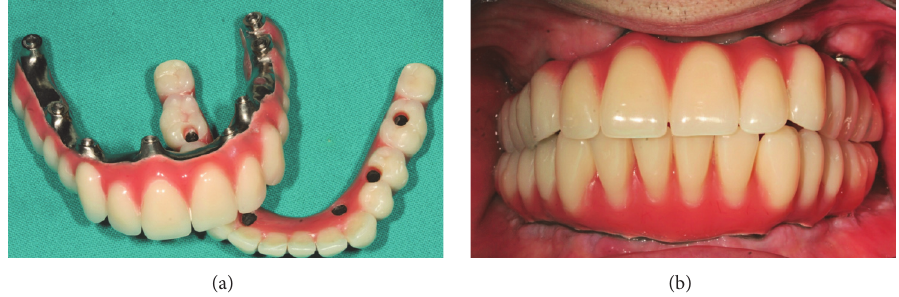
Figure 2: Final prostheses delivered to the patient at 96